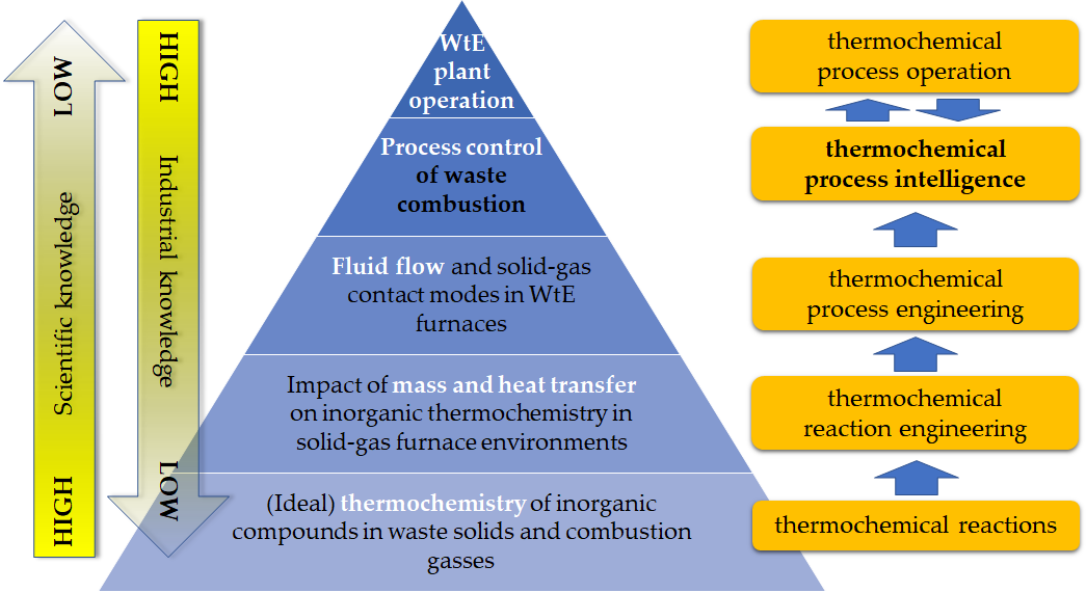
Figure 5. Knowledge-building in the field of waste-to-energy. Whilst a solid scientific basis for thermochemical properties and reactions of inorganic compounds in thermally treated waste is yet to be well established, challenges for further research and development associated with inorganic compounds in actual WtE combustion plants remain at intermediate levels. This urges increased research efforts in terms of thermochemical reaction and process engineering in order to connect the existing scientific knowledge with insights from industrial WtE plant operation (i.e., mainly empirical knowledge on thermochemical process operation). This connection can be effectively realized at the level of thermochemical process intelligence, for which predictive models still largely need to be established.